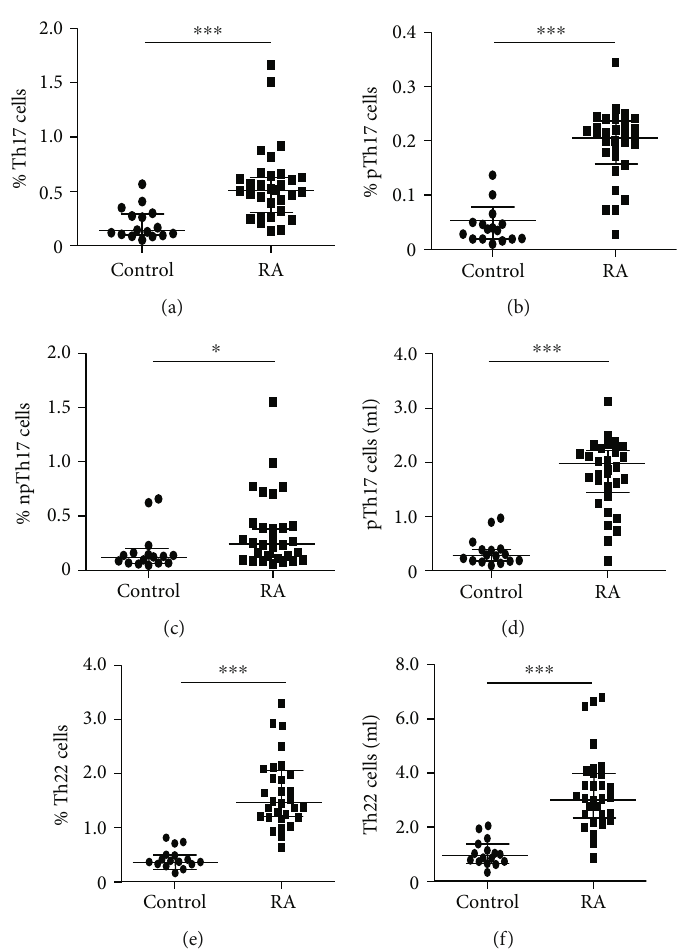
Figure 2: Levels of Th17 and Th22 lymphocytes in patients with RA. Blood samples from 30 patients with rheumatoid arthritis (RA) and 16 healthy controls (Control) were obtained and PBMC were isolated, stained, and analyzed by multiparametric fl ow cytometry, as stated in Materials and Methods and shown in Figure 1. (a) Percentages of CD4 + IL-17 + cells, referred to total lymphocytes. (b) Percentages of pathogenic Th17 (pTh17) cells referred to total lymphocytes. (c) Absolute numbers of pTh17 cells/ml. (d) Percentage of nonpathogenic Th17 (npTh17) cells, referred to total lymphocytes. (e) Percent of Th22 cells (CD4 + CXCR3 +/- IL-17 - IL-22 + ), referred to total lymphocytes. (f) Absolute numbers of Th22 lymphocytes/ml. Horizontal lines correspond to the median and Q 1 - Q 3 interquartile range. ∗ p < 0 : 05 , ∗∗∗ p < 0 : 005 (Mann – Whitney U